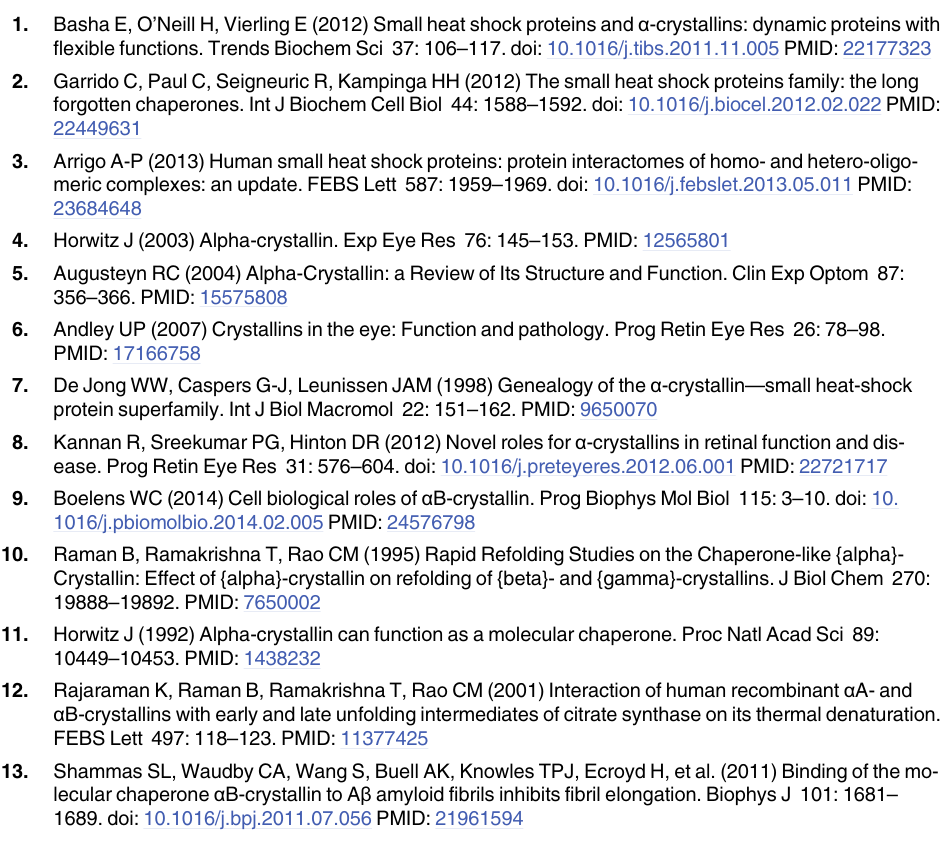
(FRTTO = 100%). Values represent mean ± SD of 3 independent experiments. (TIF) S2 Fig. Effect of the 10 human untagged HSPB family members on the aggregation of HSPB5 mutants. HEK293 cells were co-transfected with either 0.5 μ g of myc- HSPB5 (R120G) or (450 Δ A) or (464 Δ CT) and either FRTTO as a control or untagged HSPBs (HSPB1-10) at 1:3 ratio for 48 h. Cells were lysed with Triton X- 100 lysis buffer, fractionated into S (soluble) and P (pellet) fractions or T (total lysate) and western blotting was performed. (TIF) S3 Fig. HSPB1, HSPB4 but not HSPB7 prevent the aggregation of HSPB5 mutants. Confo- cal images of transfected HEK293 cells with myc-HSPB5 mutants (R120G, 450 Δ A, 464 Δ CT) and either HSPB1-V5, HSPB4-V5 or HSPB7-V5 at 1:3 ratio. After 48 h, Cells were fixed and immunostained with mouse anti myc and rabbit anti V5 antibodies. DAPI was used to stain the nuclei. Scale bar ~10 μ